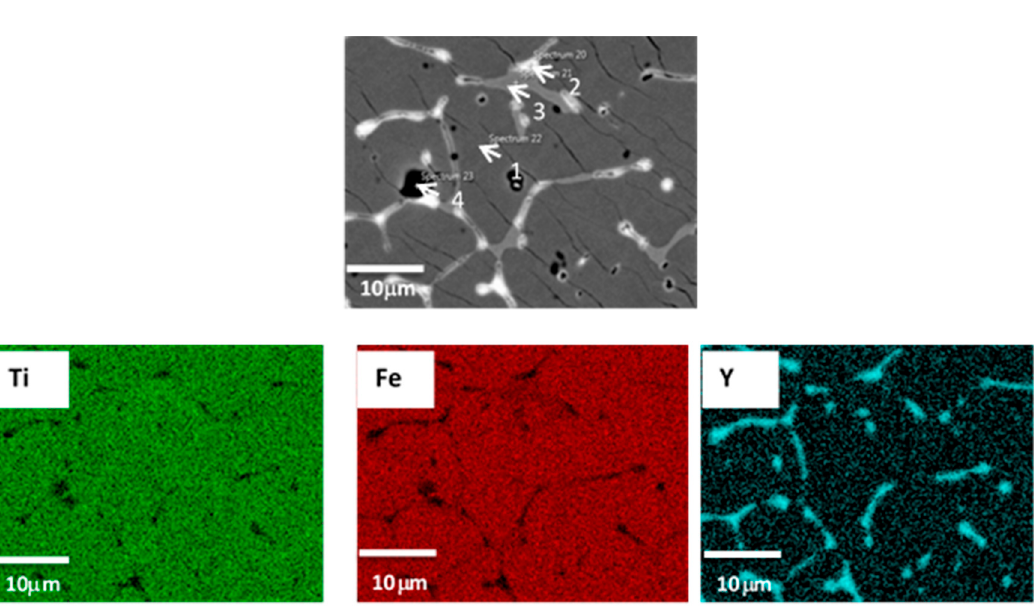
Table 1. Nominal and measured bulk atomic abundance of TiFe + x wt.% Y ( x = 4, 6, and 8). All values are in at.%. The error on each value is ± 1 at.%.